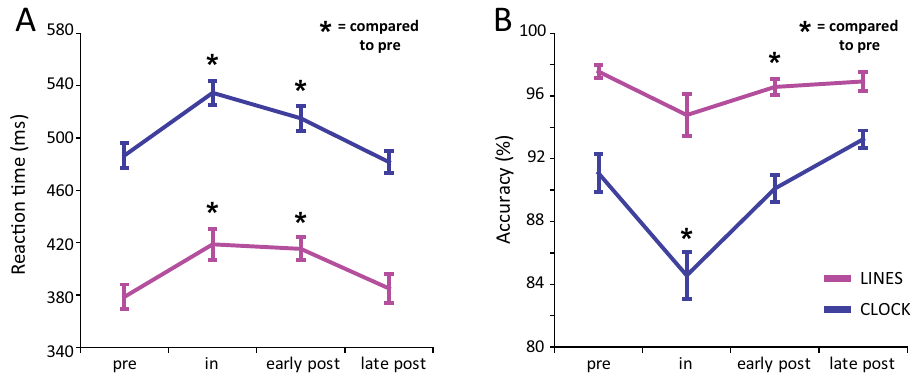
Figure 2. Task performance in the Lines and the Clock task. ( A ) Mean reaction times (corrected for practice effect). Reaction times were significantly slower during space travel compared to pre-flight. Reactions remained slower during early post-flight, but returned to pre-flight levels for late post-flight sessions. ( B ) Mean task accuracy. Accuracy decreased in space in the Clock task. Despite the similar trend, accuracy in the Lines task remained unchanged in space. Accuracy returned to pre-flight levels for late post-flight sessions in both tasks. Error bars represent within-subjects standard error of mean (SEM) 23 . * P <